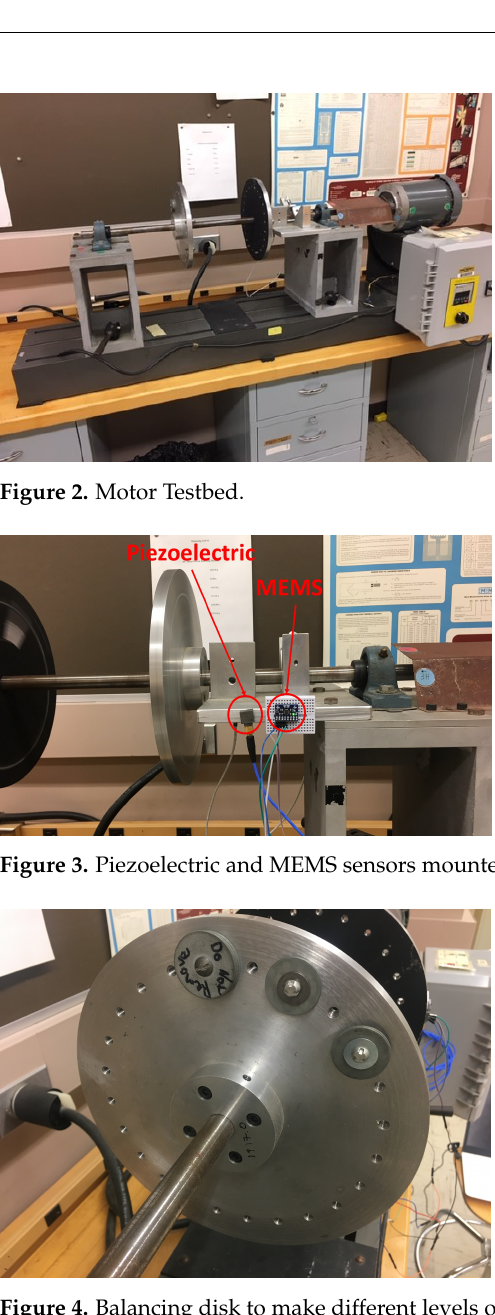
Figure 4. Balancing disk to make different levels of